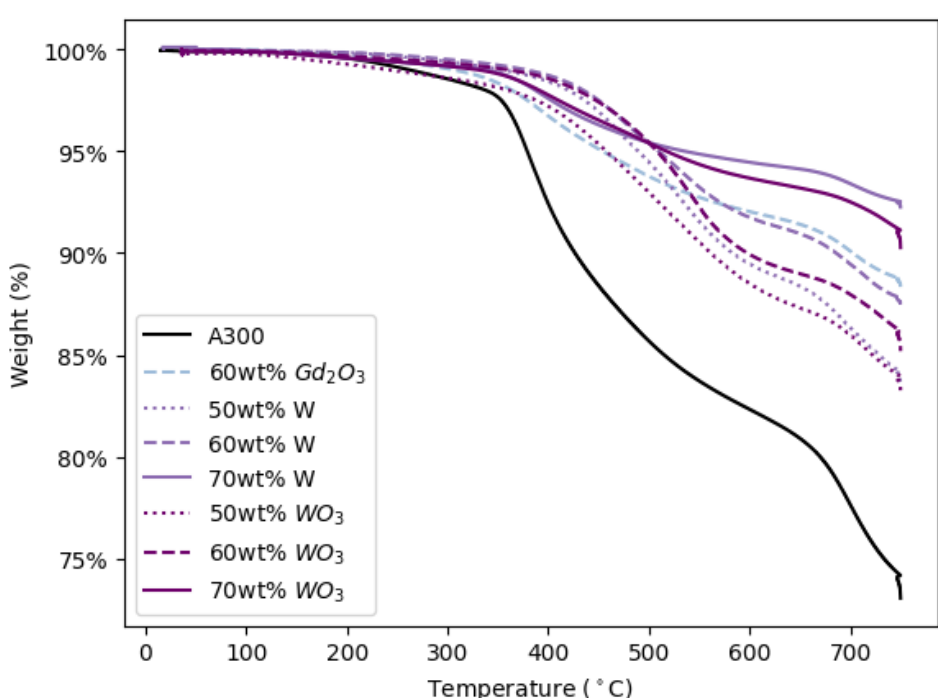
Figure 16. Schematic of thermal conductivity pathways in pads with: ( a ) SC lattice structure and ( b ) FCT lattice structure.